Question: Briefly state, in one sentence, what is plotted here.
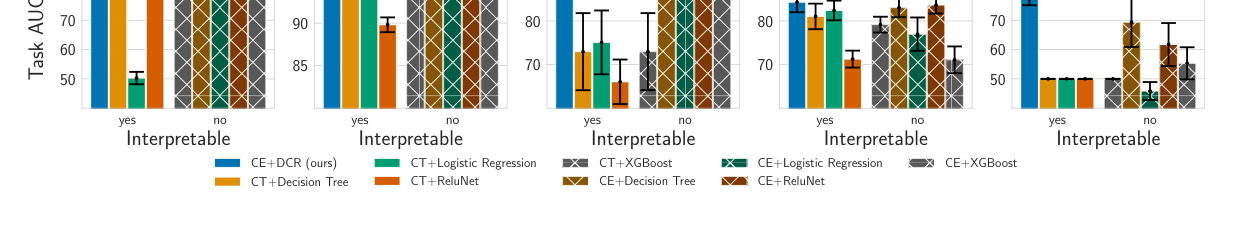
Answer: Mean ROC AUC for task predictions for all baselines across all tasks (the higher the better). DCR often outperforms interpretable concept-based models. CE stands for concept embeddings, while CT for concept truth degrees. Models trained on concept embeddings are not interpretable as concept embeddings lack a clear semantic for individual embedding dimensions.